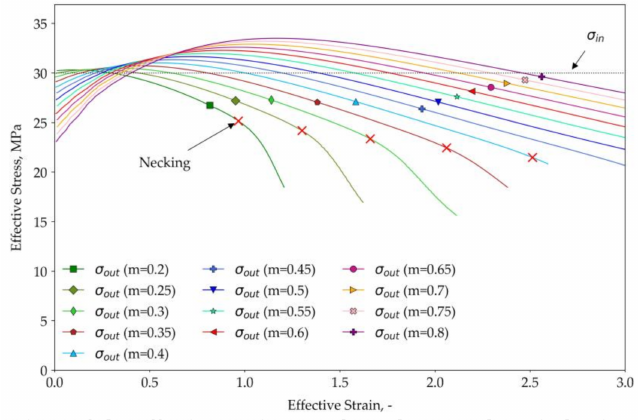
Figure 5. The e ff ect of strain-rate sensitivity ( m ) on the stress–strain curves obtained by tensile